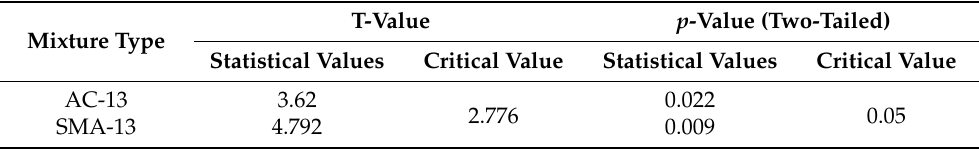
Table 8. T-test of BPN from 20,000 to 24,000 abrasive cycles.